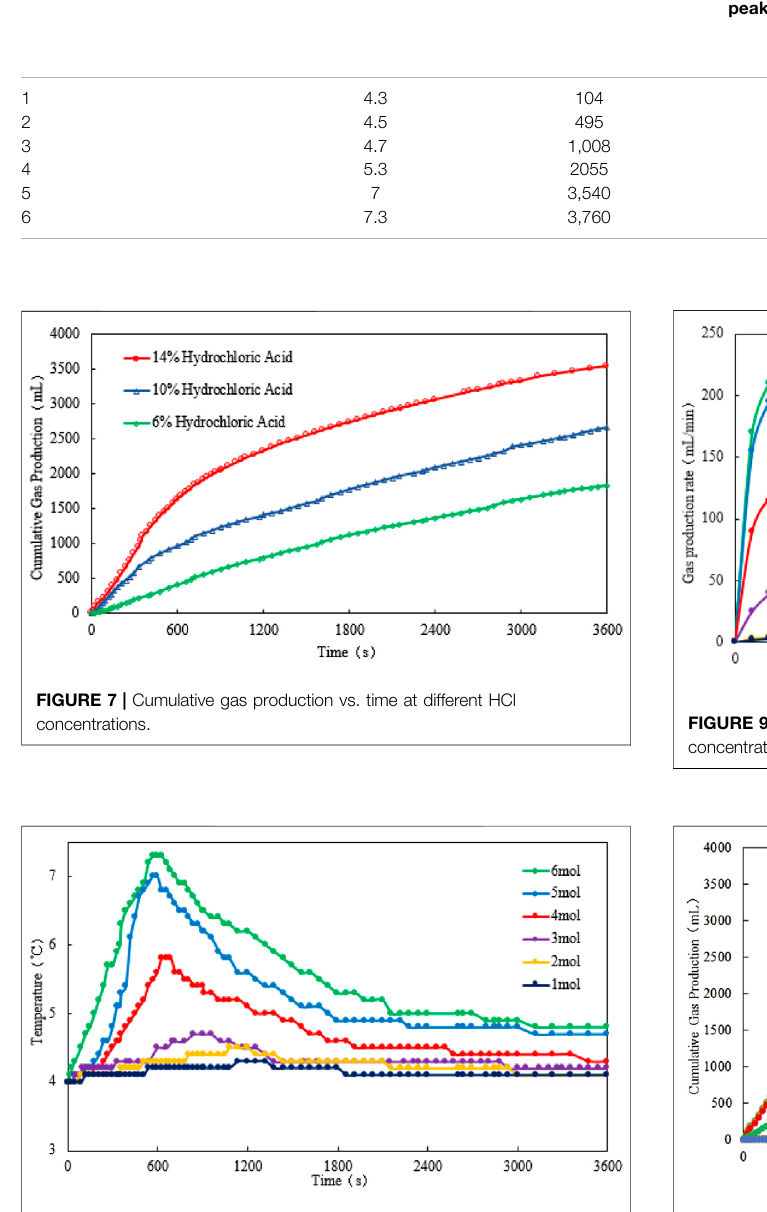
FIGURE 10 | Cumulative gas production vs. time at different reactant